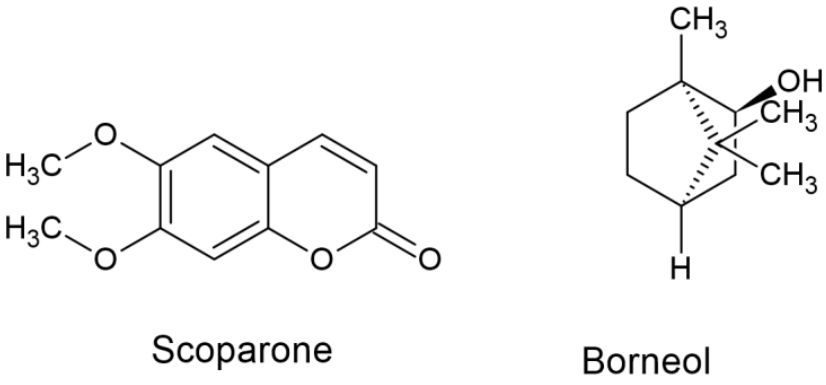
Figure 1. Chemical structure of scoparone and borneol.